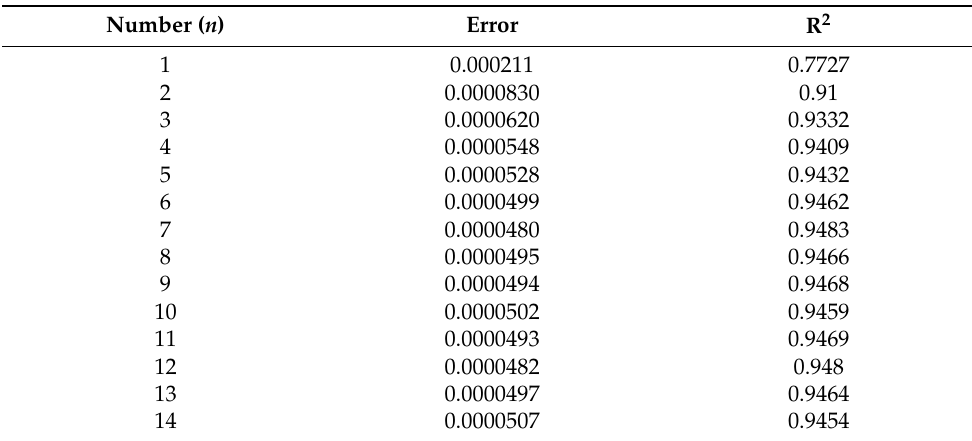
Figure 5. Spatial distribution of 1590 farmland quality samples. Table 4. Corresponding errors for different values of n and their R 2 .